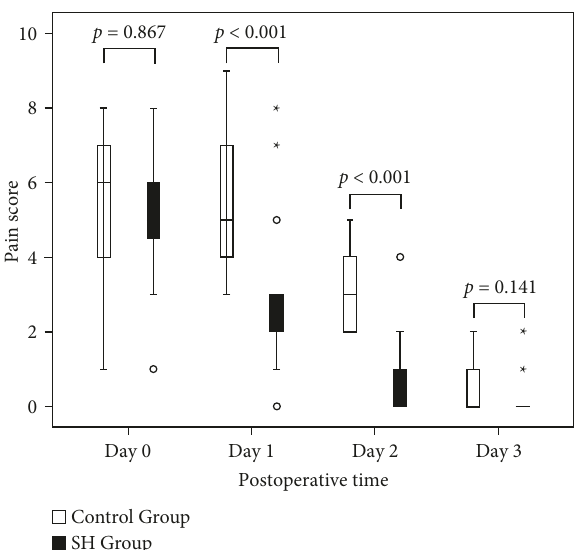
Figure 5: A comparison of the box plot of pain scores of the SH and the control groups on Days 0, 1, 2, and 3. The boxes represent the interquartile range (IQR). Medians are indicated by a thick horizontal line inside the box. The distribution of medians is shown by the thick horizontal lines outside the box. Outliers are depicted by individual circles and stars.